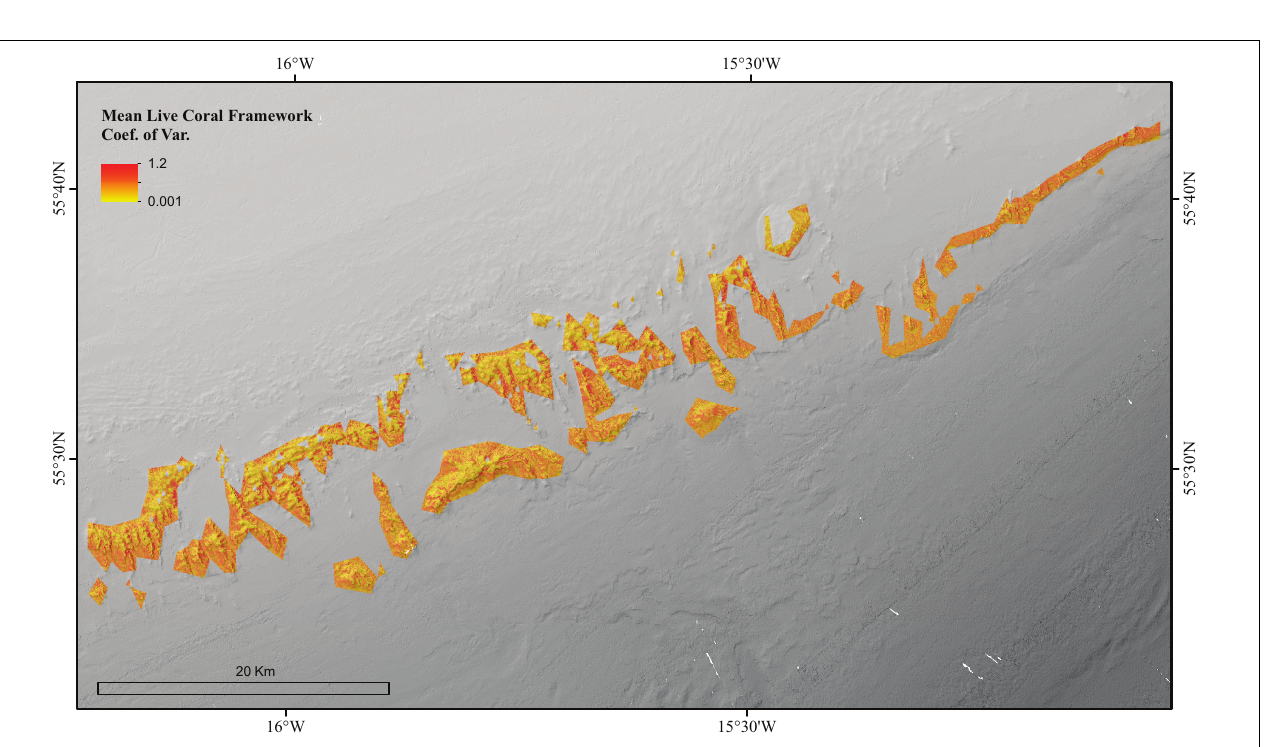
FIGURE 6 | The Coefficient of Variation for the Random Forest model of the mean biomass for live coral framework in the coral reef habitat area of the Logachev Mound Province.